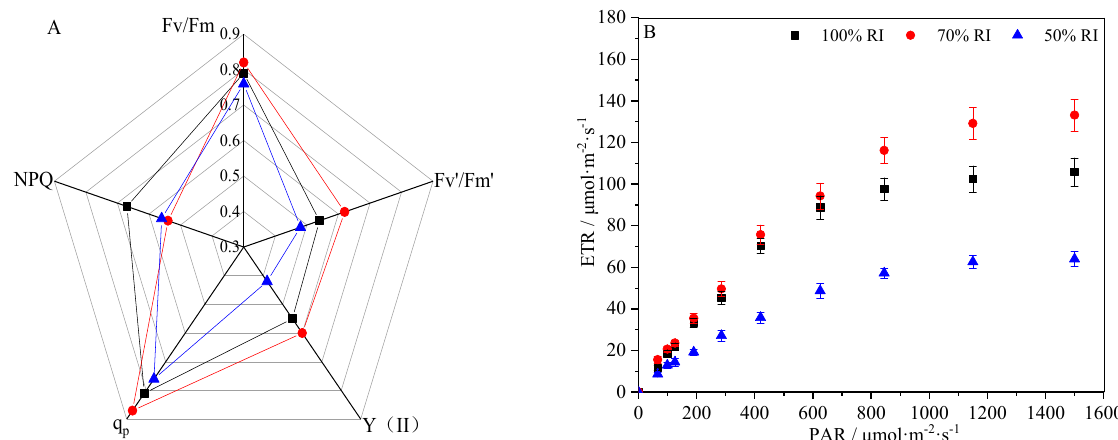
Figure 3. Comparison of chlorophyll fluorescence parameters of P. massoniana seedlings under different light treatments (means ± SDs), n = 6. The letters denote: ( A ) the slow induction kinetics parameters of dark-adapted leaves; ( B ) relative electron transfer rate of PSII at 0-1500 µmol·m − 2 ·s − 1 . Abbreviations: RI, relative irradiance; Fv/Fm, maximum photochemical efficiency; Y(II), actual quantum yield; q p , photochemical quenching; NPQ, non-photochemical quenching; ETR, relative electron transfer rate. Significant differences are indicated: p < 0.05.